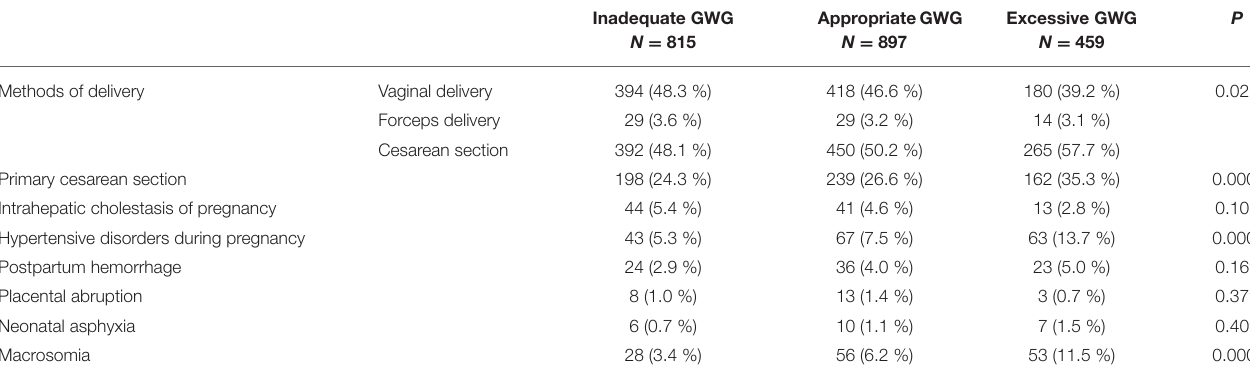
TABLE 2 | Comparison of pregnancy outcomes in gestational diabetic women with different weight gains during